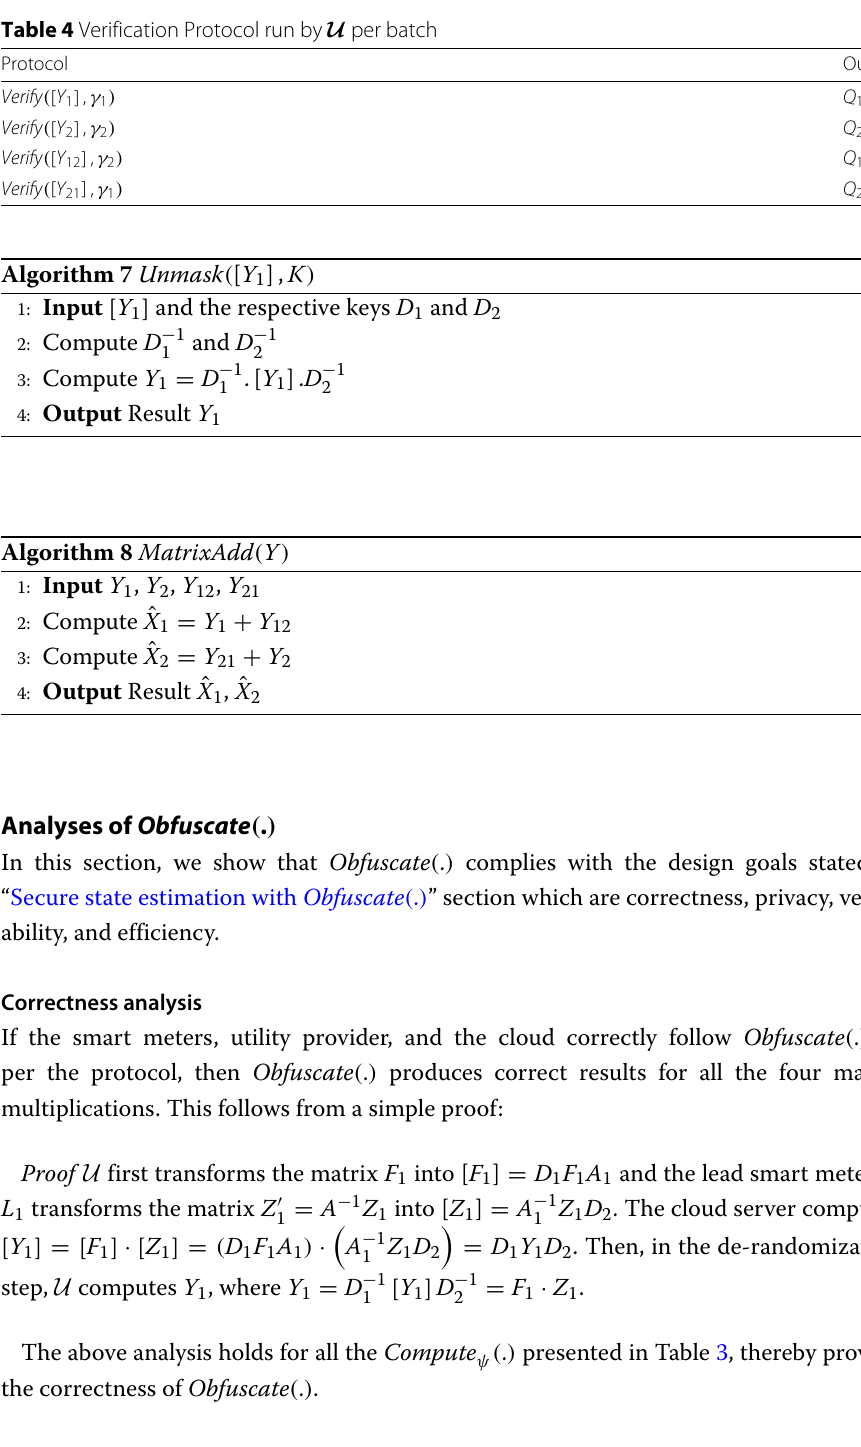
Table 5 Unmasking Protocol run by